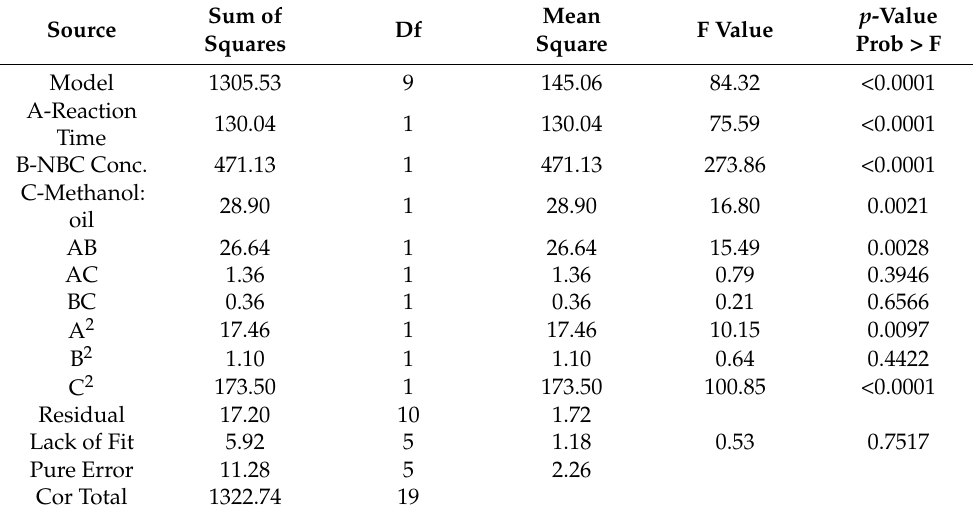
Table 2. ANOVA for the quadratic model for percentage biodiesel